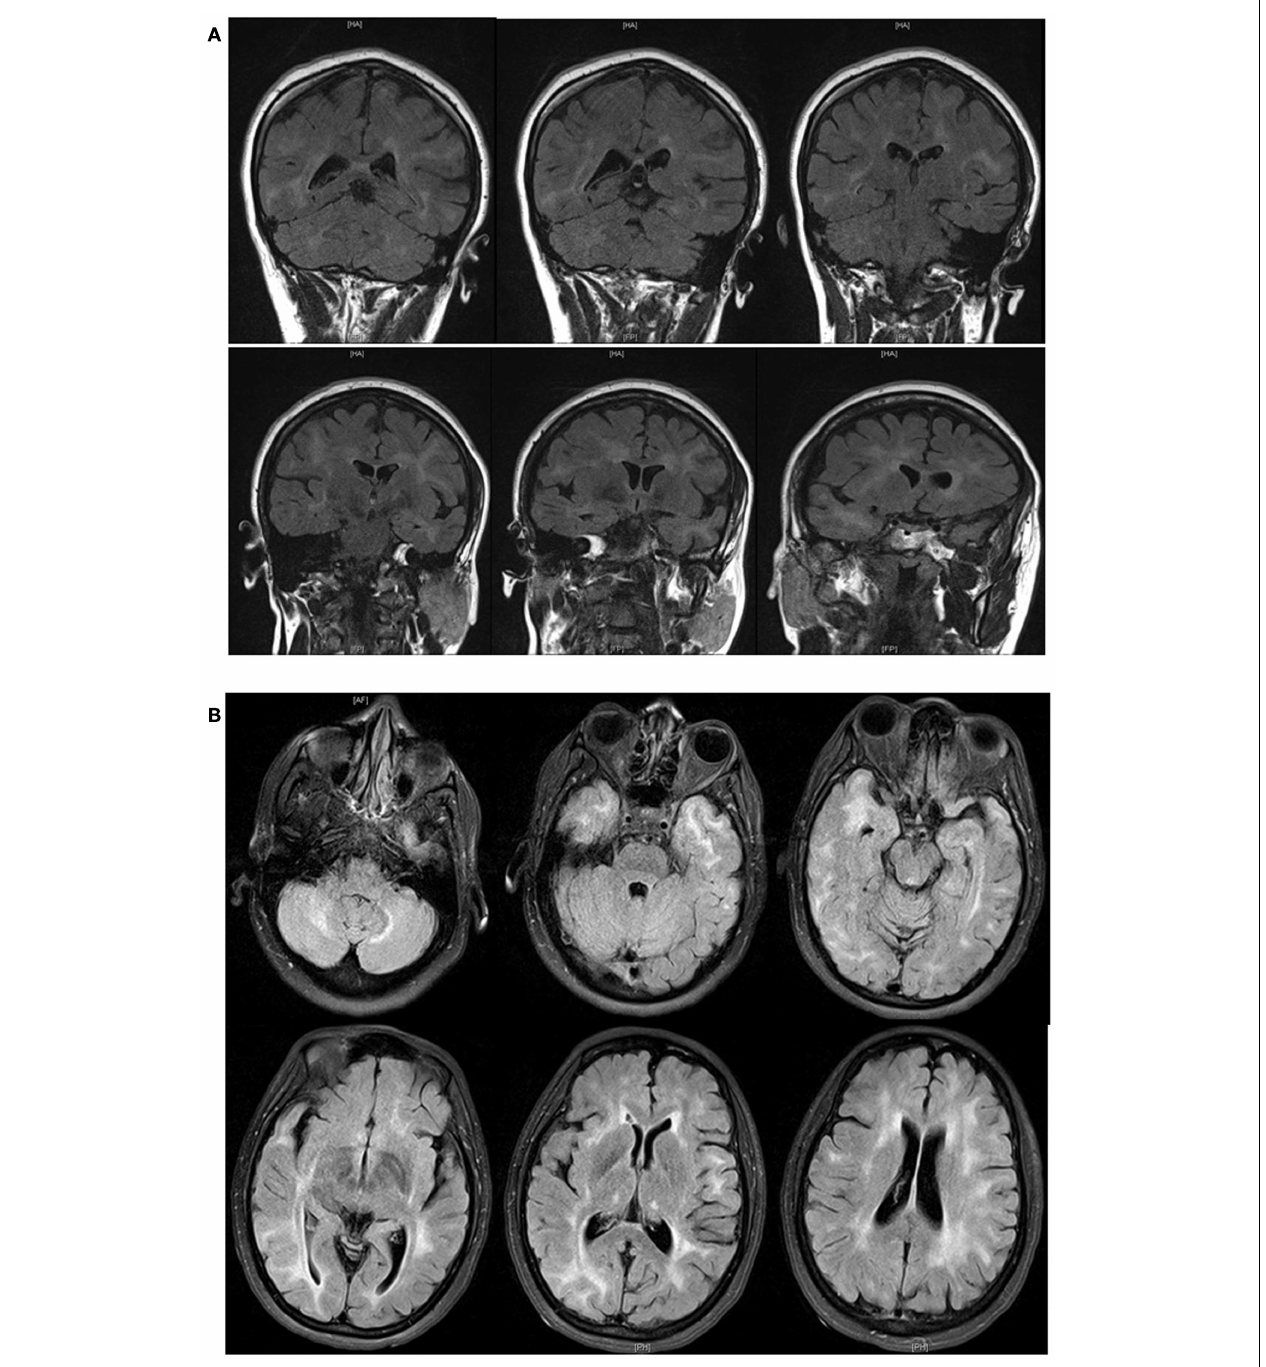
FIGURE 1 | Fluid attenuated inversion recovery (FLAIR) MRI [(A),coronal; (B), axial] demonstrated showing diffuse abnormalities involving the periventricular and subcortical white matter of both cerebral hemispheres, areas of punctate hyperintensities on both thalami, and foci of hyperintense signal on both cerebellar